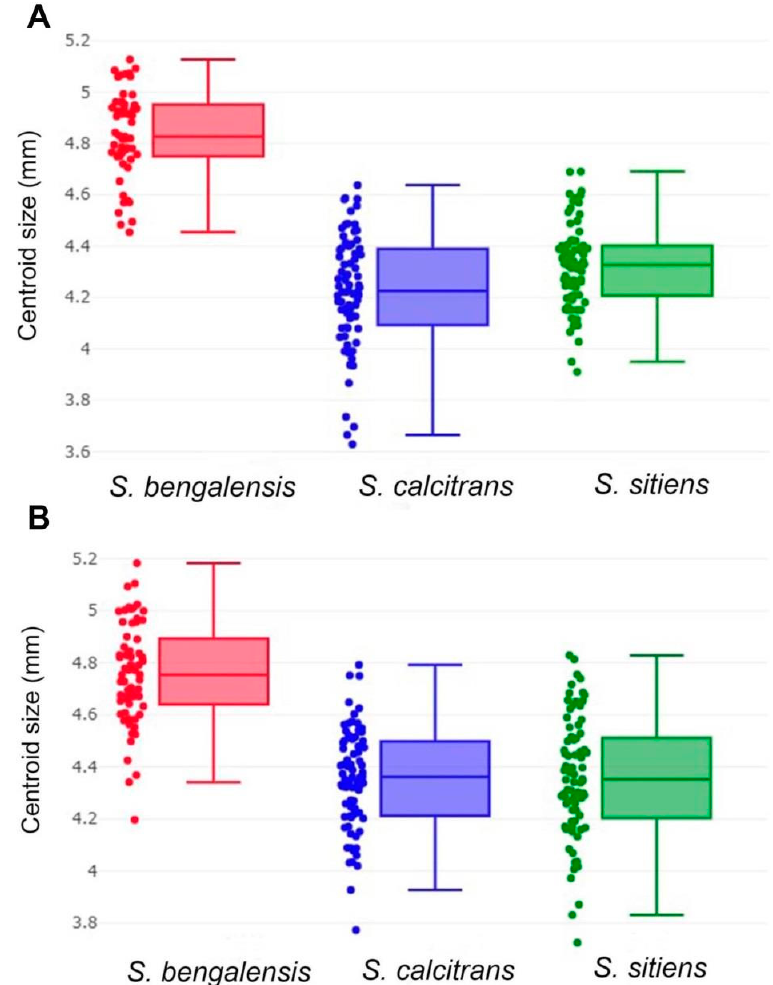
Figure 7. Boxplots of the centroid size variations of male ( A ) and female ( B ) Stomoxys bengalensis , S. calcitrans , and S. sitiens . The horizontal line that crosses each box represents the median, separating the 25th and 75th quartiles. Table 2. Mean centroid size of male and female Stomoxys bengalensis , S. calcitrans , and S. sitiens and statistically significant differences.